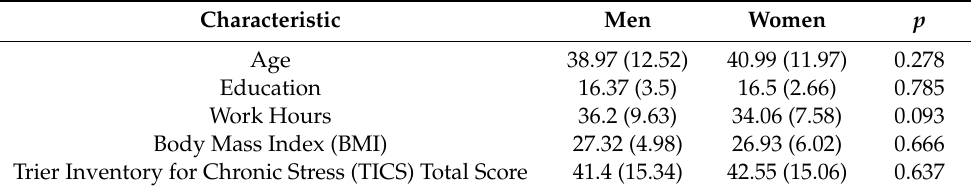
Table 1. Participant characteristics for men and women, with averages (standard deviations) and significance level of independent t-tests.